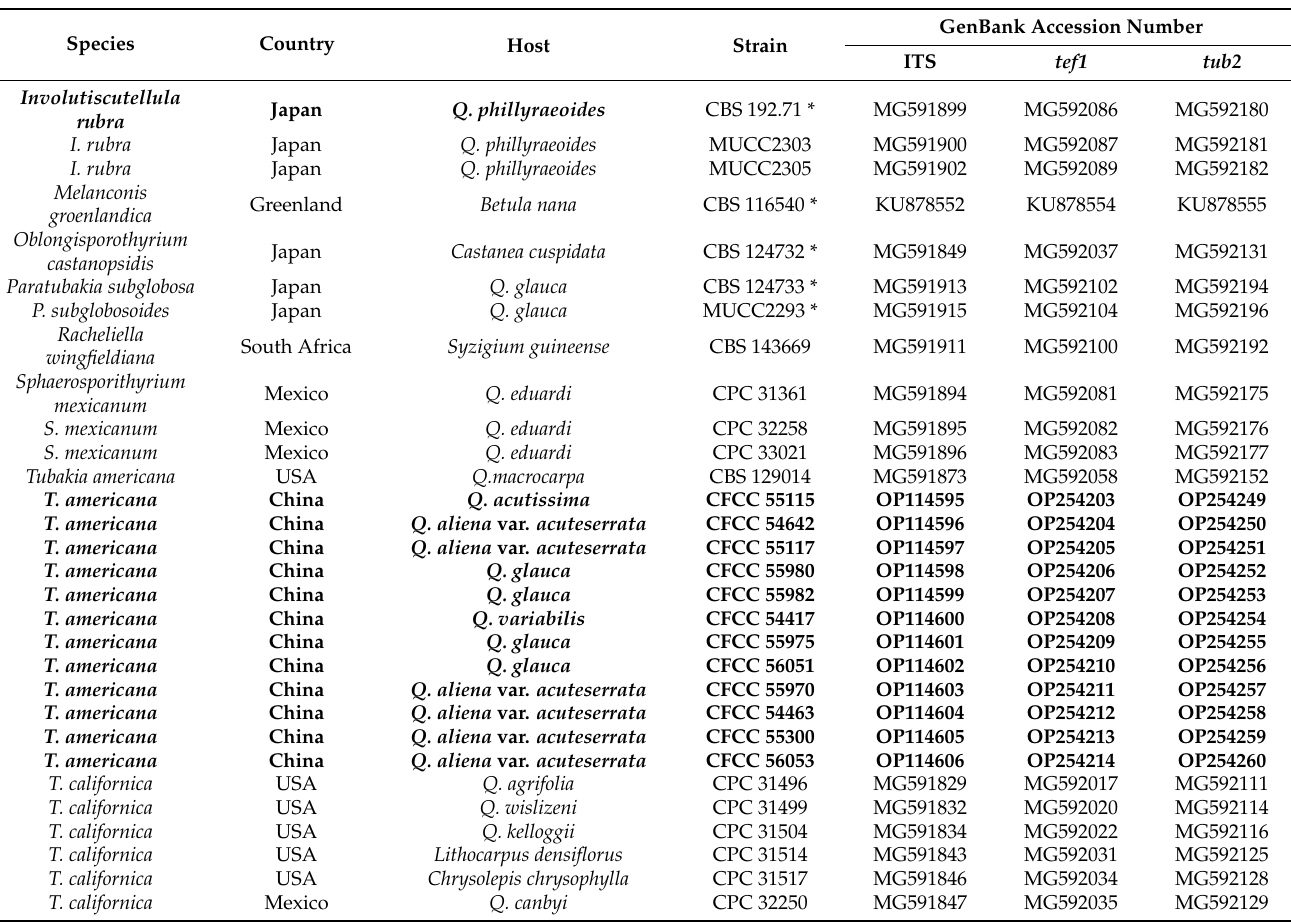
Table 2. Strains and GenBank accession numbers used in this